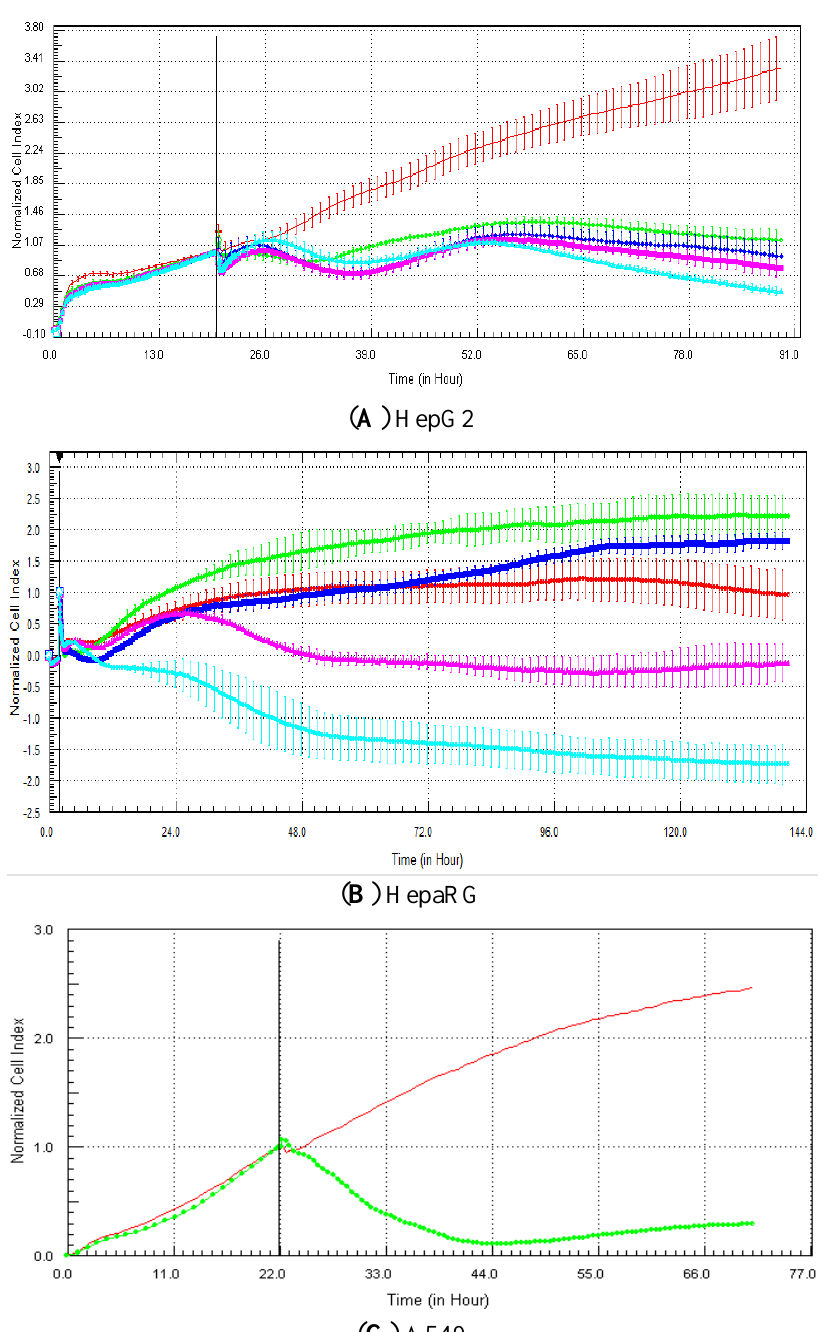
Figure 4. Effect of nocodazole (antimitotic) on cell index curves (RTCA) in HepG2, fresh HepaRG and A549 cells. HepG2 ( A ) and HepaRG ( B ) cells were exposed for at least 72 h to 0 (0.5% DMSO, red curve), 0.1 (green curve), 1 (dark blue curve), 10 (purple curve) and 100 (light blue curve) µM and A549 cells to 0 (control DMSO, red curve) and 20 µM (green curve) of nocodazole ( C from Abassi et al. [9]). Cell indexes were normalized with the last time point before compound addition. Panels A and B: each data point was calculated from triplicate values (except for control cells n = 6). Data represent the average ± standard deviation (except for panel C). The normalized time point is indicated by the vertical line. For more details, please refer to the Materials and Methods